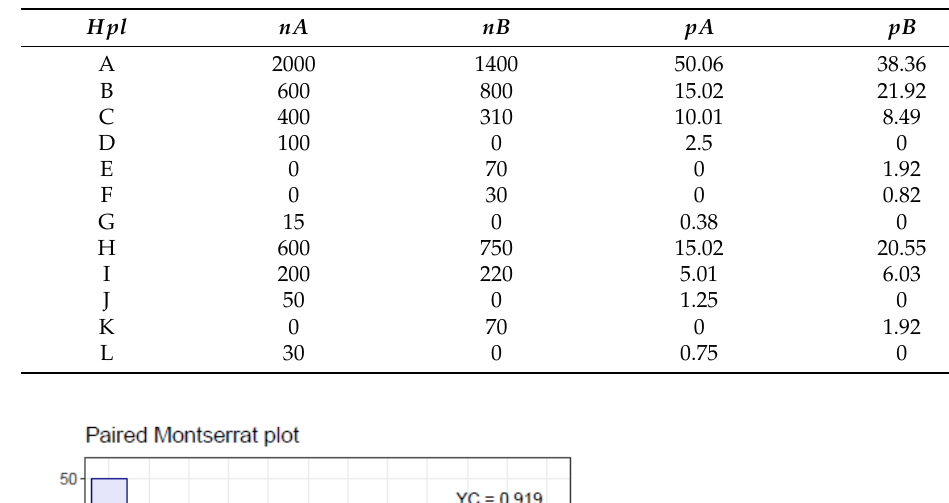
Table 1. Two closely related quasispecies. Hpl haplotype ID, nA reads in quasispecies A, nB reads in quasispecies B, pA and pB corresponding frequencies (%).